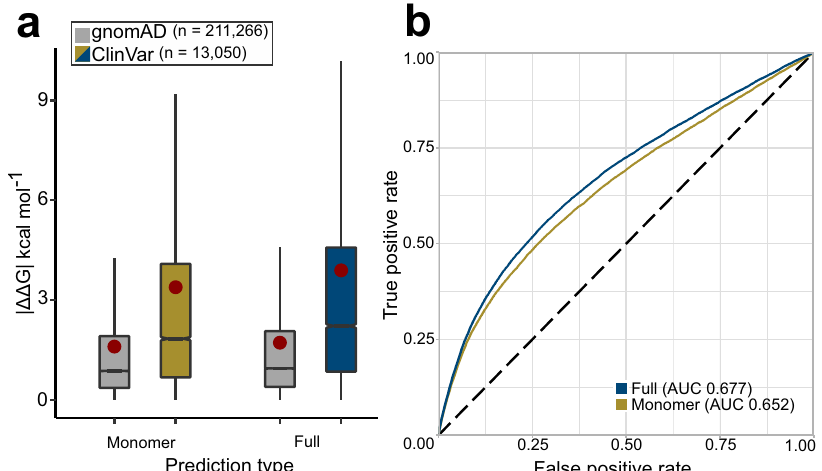
Fig. 1 Using full protein complex structures improves discrimination between pathogenic and putatively benign missense variants. a Comparison of predicted | ΔΔ G | values for putatively benign gnomAD and pathogenic ClinVar mutations when calculated using monomer structures only, or by also employing full biological assemblies and therefore also considering intermolecular interactions. Boxes denote data within 25th and 75th percentiles, and contain median (middle line) and mean (red dot) value notations. Whiskers extend from the box to furthest values within 1.5x the inter-quartile range. All pairwise group comparisons (both between and within prediction types) are signi fi cant (p < 2.5 × 10 − 28 , two-sided Dunn ’ s test for multiple pairwise comparisons, corrected for multiple testing by Holm ’ s method; see ‘ Methods ’ ). b Receiver operating characteristic (ROC) curves and area under the curve (AUC) for discrimination between ClinVar and gnomAD mutations using monomer and full | ΔΔ G | values. Source data are provided as a Source Data fi